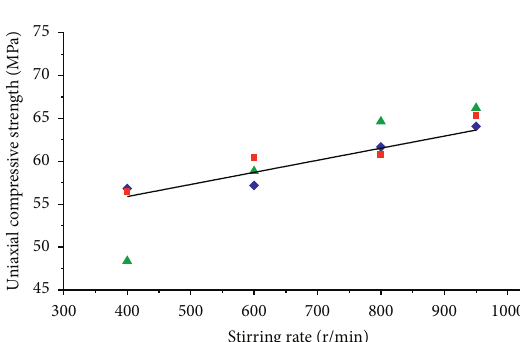
Figure 13: Relationship between bubble section and